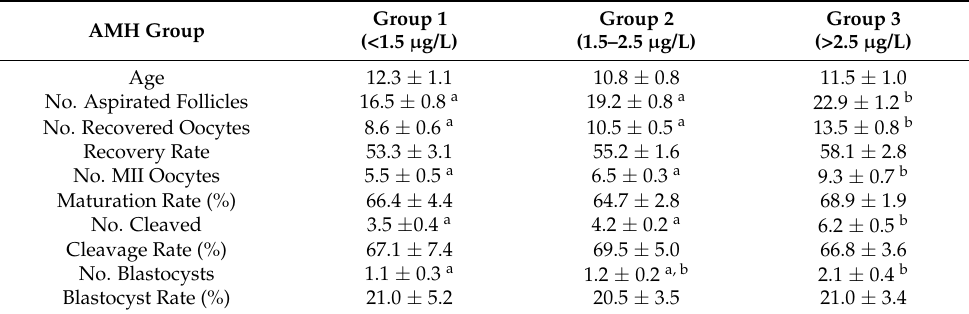
AMH = anti-Müllerian hormone. OPU = ovum pick-up. ICSI = intracytoplasmic sperm injection. No = Number of. MII Oocytes = Oocytes in Metaphase II. Cleaved = Cleaved embryos on Day 2–3. Recovery Rate = No. Oocytes Recovered/No. Follicles Aspirated. Maturation Rate = No. MII Oocytes/No. Oocytes Recovered. Cleavage Table 1. Effect of serum AMH concentration on the OPU-ICSI outcome in mares. Rate = No. Cleaved embryos/No. MII Oocytes. Blastocyst Rate = No. Blastocysts/No. MII oocytes. Data are shown as mean value ± standard error of the mean (SEM). Within rows, different superscript letters (a,b) indicate significant differences ( p < 0.05). The absence of superscripts indicates the lack of statistical differences between groups ( p >